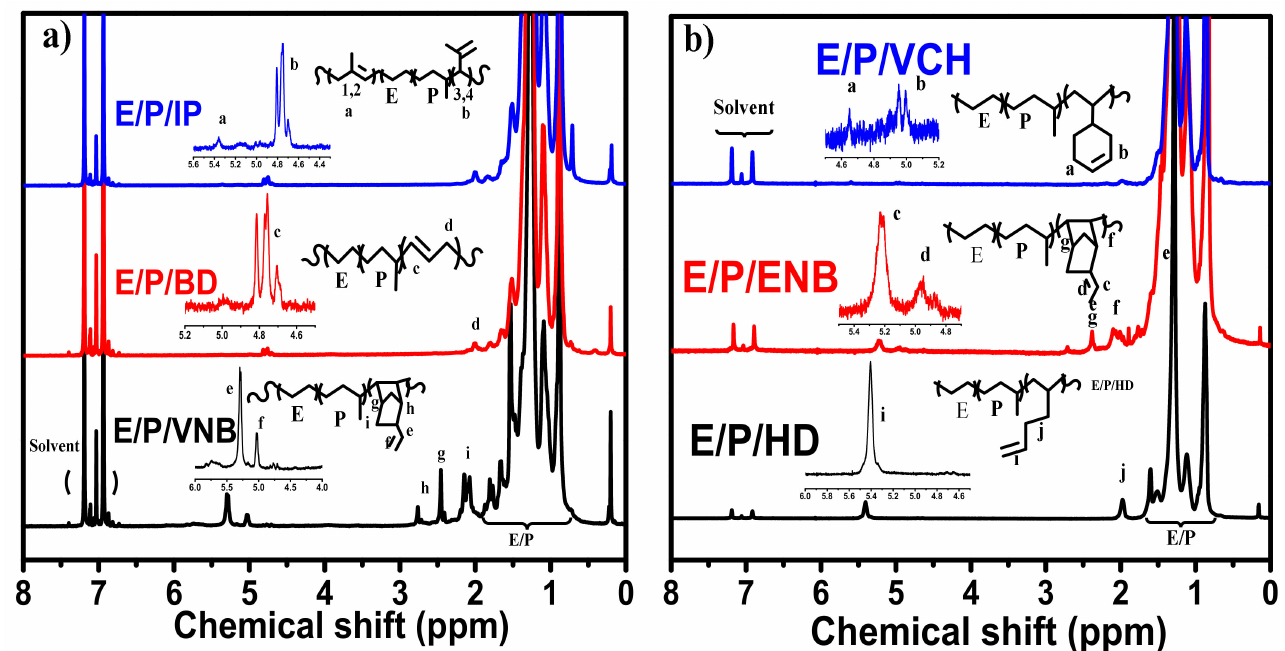
Figure 8. Chain structure of ethylene/propylene/diene terpolymerizations.